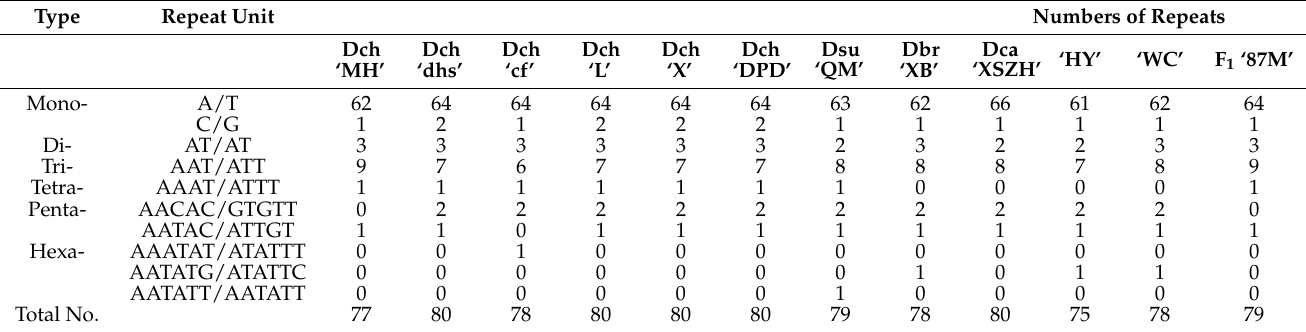
Table 3. Type and number of SSRs found in the Dianthus